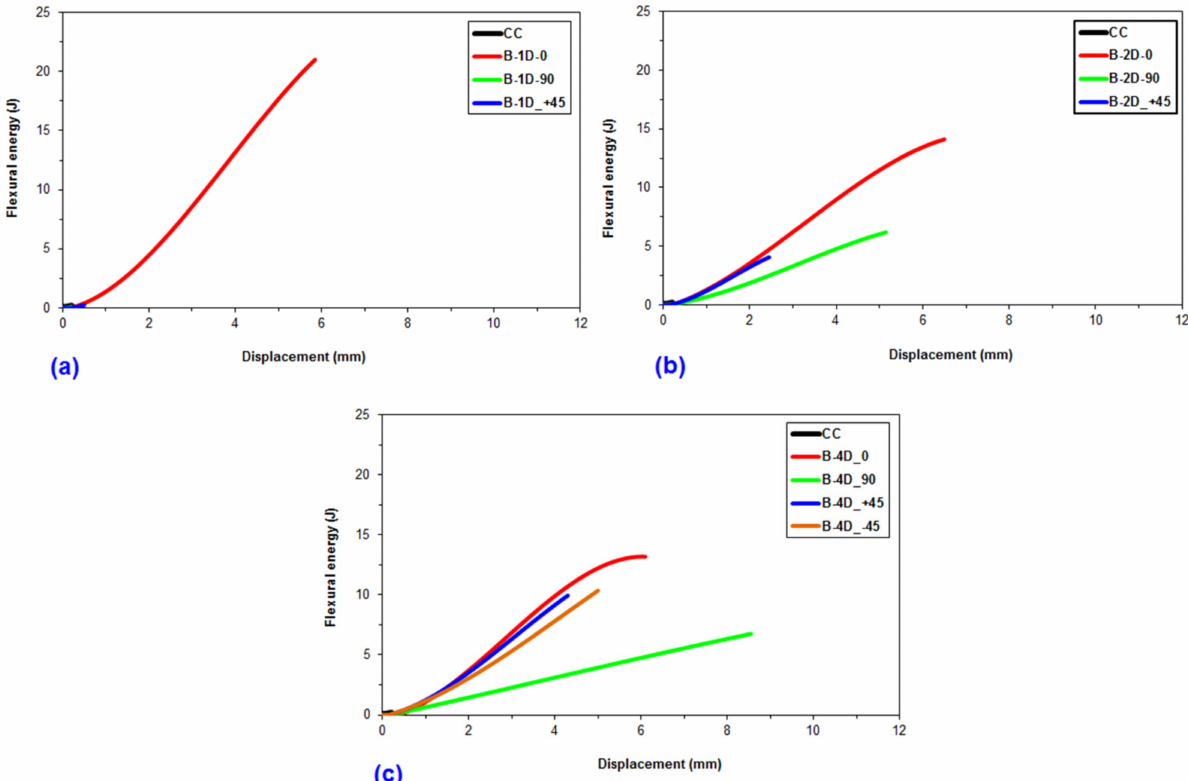
Figure 13. Flexure energy-displacement graphs of the multiaxis 3D basalt fiber TOWs concretes after the off-axis four-point